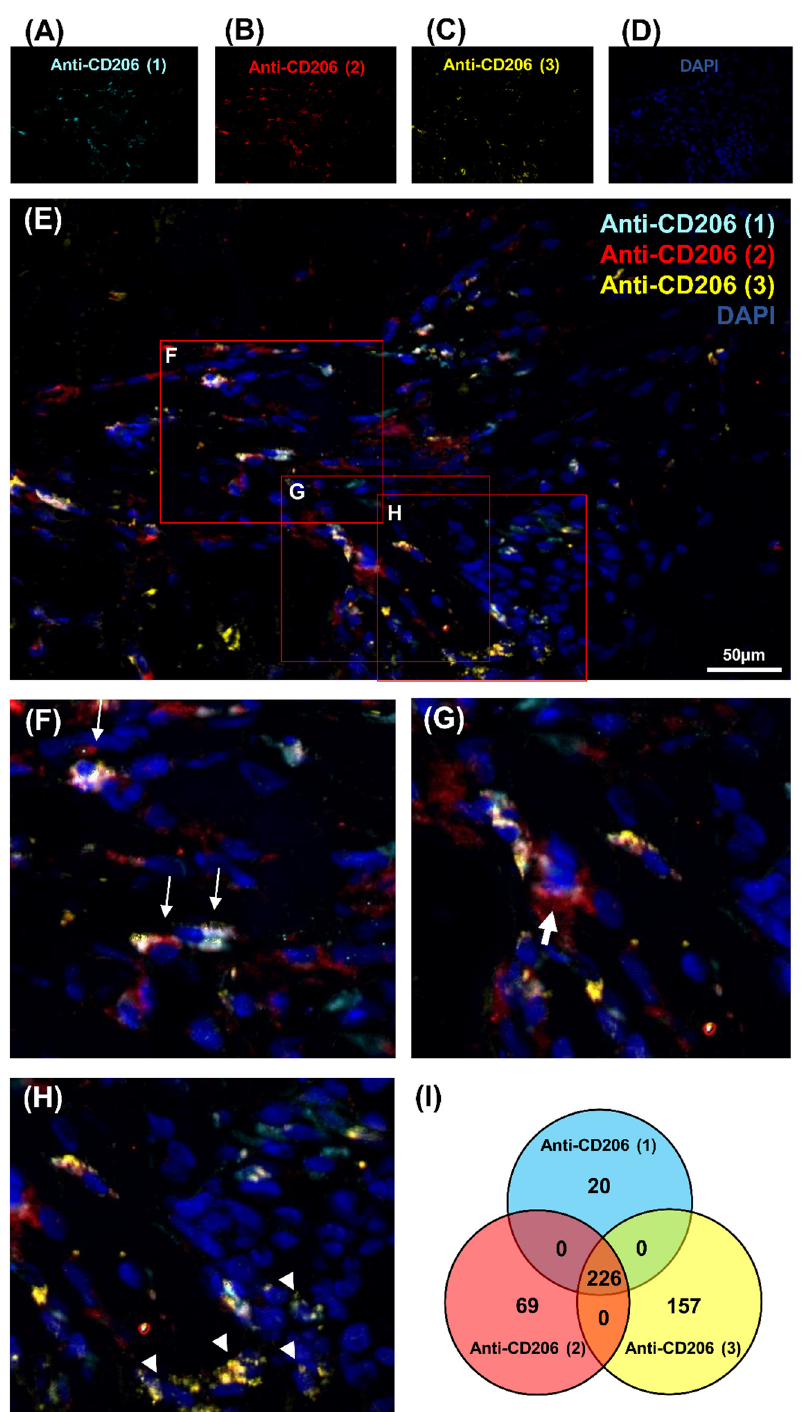
Figure 1. Detection of CD206 marker expression in cells in IR-ASC muscle by immunofluorescence method. ( A ) Anti-CD206 (1) (Alexa488, turquoise fluorescence), ( B ) Anti-CD206 (2) (Alexa488, red fluorescence), ( C ) Anti-CD206 (3) (Alexa488, yellow fluorescence) labeling, ( D ) Nuclear staining with DAPI (blue fluorescence). ( E ) Merged image, ( F – H ) expanded view: high magnification image of the area within the red rectangles in image E. ( I ) Venn diagram of CD206-positive cells of 3000 cells. Thin arrow: cells labeled with three antibodies; thick arrow: cells labeled with Anti-CD206 (2) antibody only; arrowhead: cells labeled with Anti-CD206 (3) antibody only.